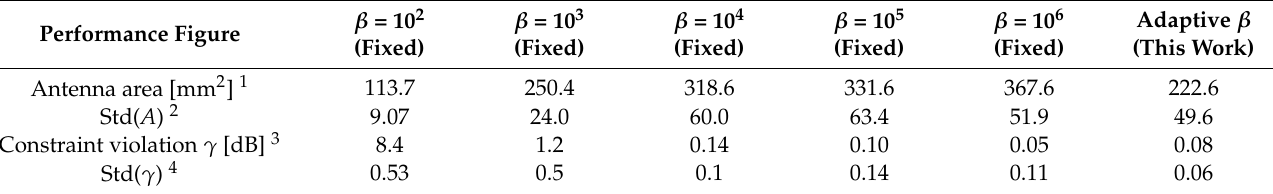
Figure 4. Geometry of Antenna I. The light gray shade is the ground plane on the backside of the structure.